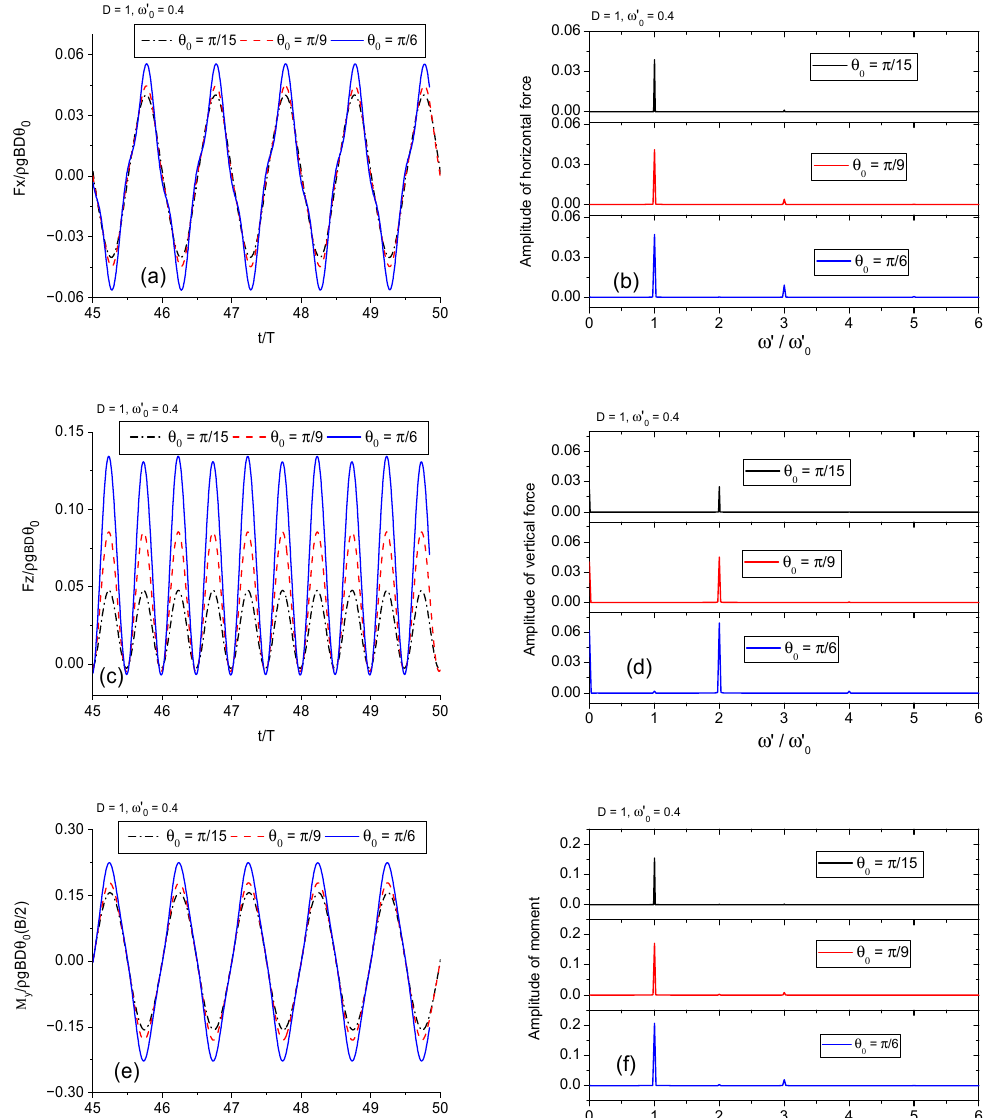
Figure 14. Normalized forces and moments histories of different amplitudes and their FFT analysis when D = 1, ω (cid:48) 0 = 0.4: ( a ) horizontal force histories; ( b ) FFT analysis of horizontal forces; ( c ) vertical force histories; ( d ) FFT analysis of vertical forces; ( e ) moment histories; ( f ) FFT analysis of moment.